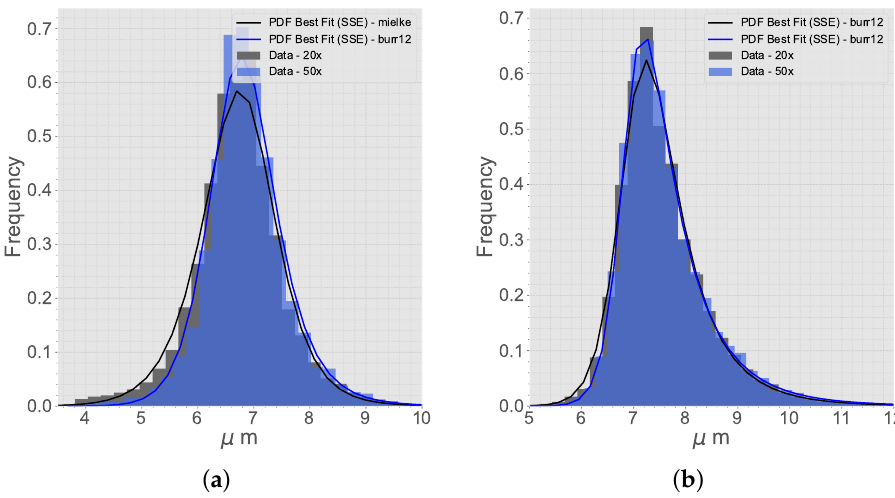
Figure 9. The best distribution functions of ( a ) first NN and ( b ) second NN, comparing the data from micrographs with 20 × and 50 × magnification.